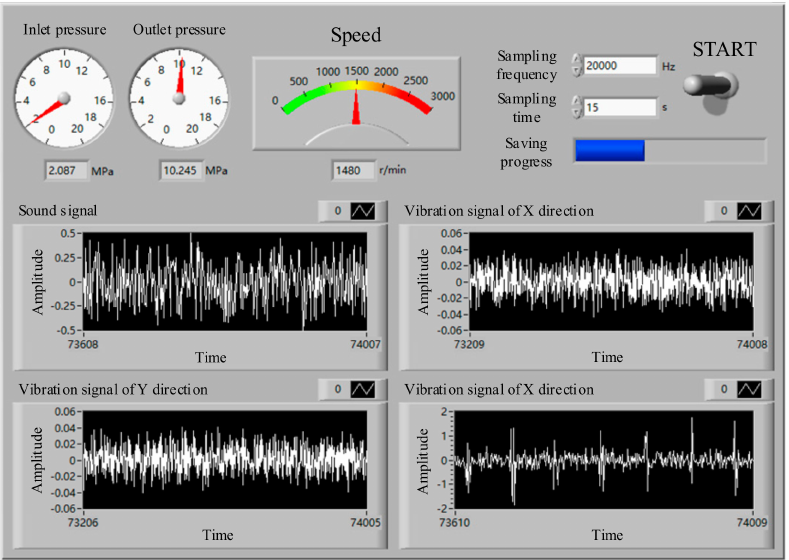
Figure 4. Front panel of the LabVIEW